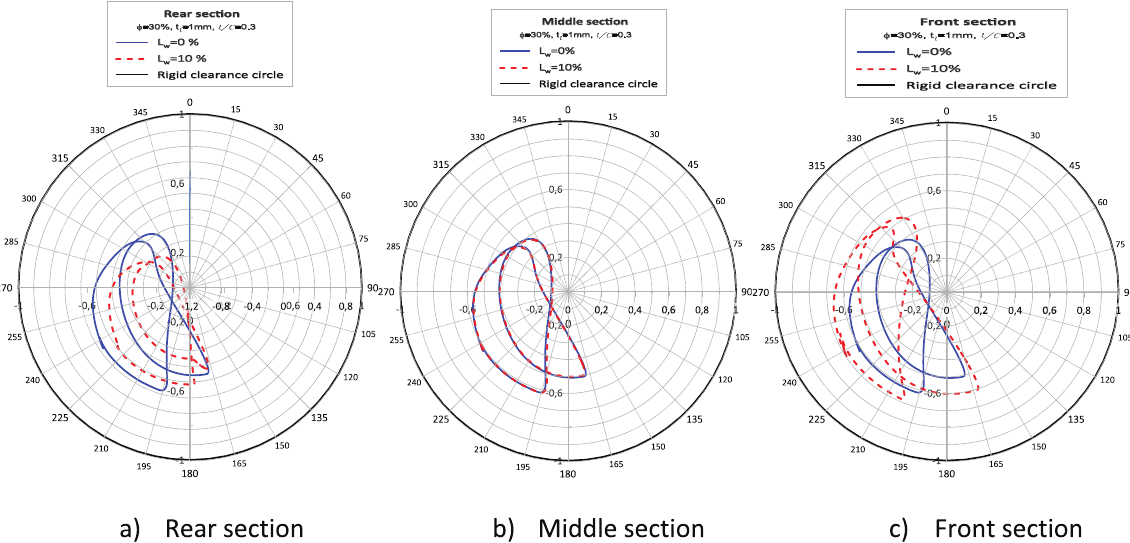
Fig. 8. Effects of the dynamic misalignment parameter L W on the stationary Journal center orbits for the non-Newtonian